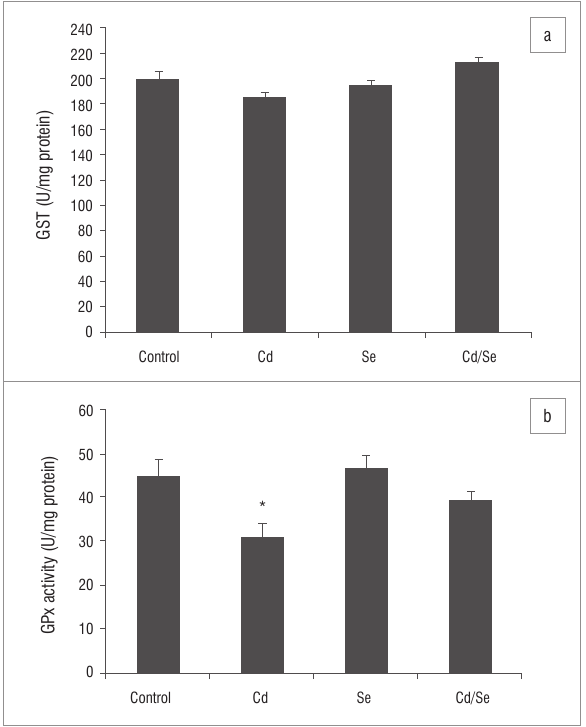
Figure 6: Mean±SD (a) glutathione s-transferase (GST) and (b) glutathione peroxidase (GPx) activities in the testes of male rats ( n =5) that received cadmium (1.67 mg/kg cadmium chloride in saline), selenium (0.23 mg/kg sodium selenite solution), cadmium and selenium (Cd/Se; 1.67 mg/kg cadmium chloride in saline and 0.23 mg/kg sodium selenite solution) or saline (control) daily (IP) for 15 days.